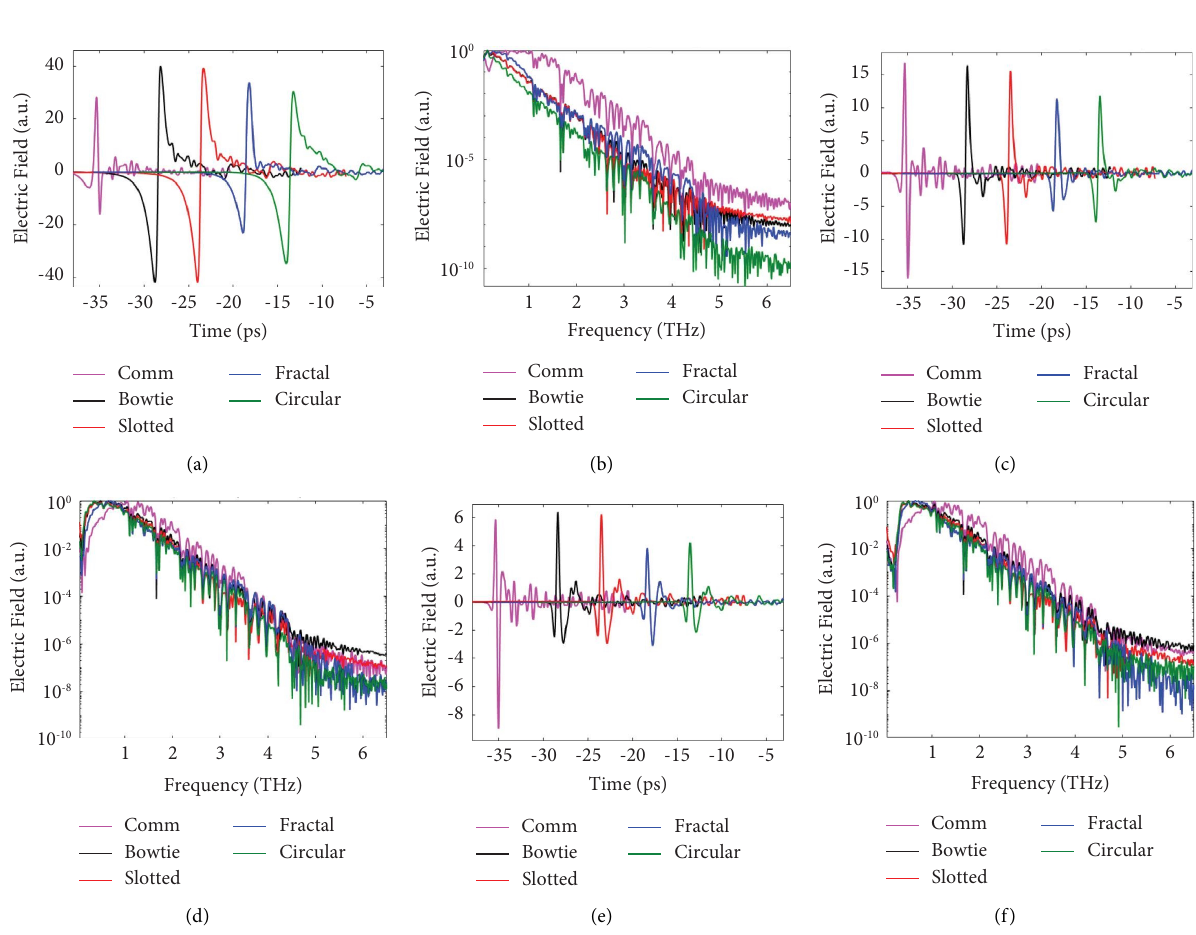
Figure 8: Experimental measurements of THz radiated signals of the bowtie, slotted, fractal, circular PCAs and a commercial PCA. (a) Time-domain pulses, (b) frequency-domain spectrum obtained using FFT. Both a and b are obtained without using pinholes. (c, d) Figures obtained using a 1mm pinhole. (e, f) Figures obtained using a 0.5mm pinhole. Te spikes in the spectrum indicate to water signatures as experiments were conducted in the air without purging with nitrogen gas. Each spectrum is normalized to its maximum